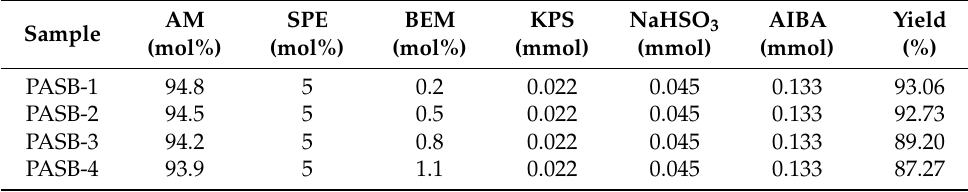
Table 2. The feeding composition of copolymers